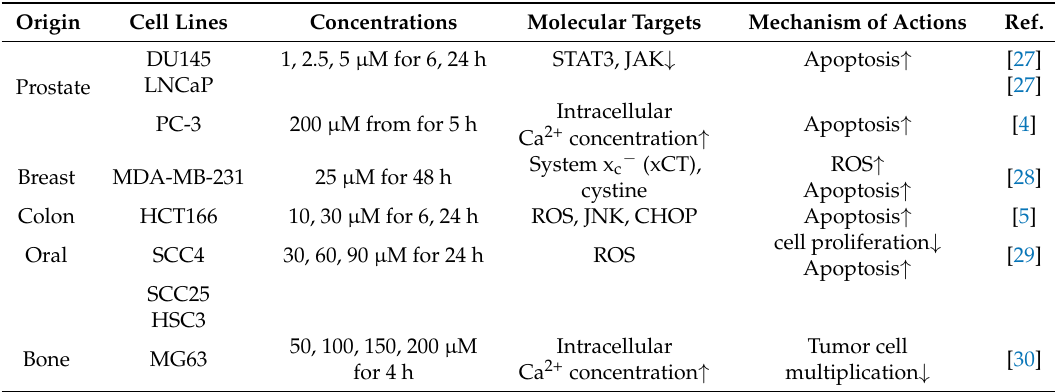
Table 1. Anti-cancer effects of capsazepine in